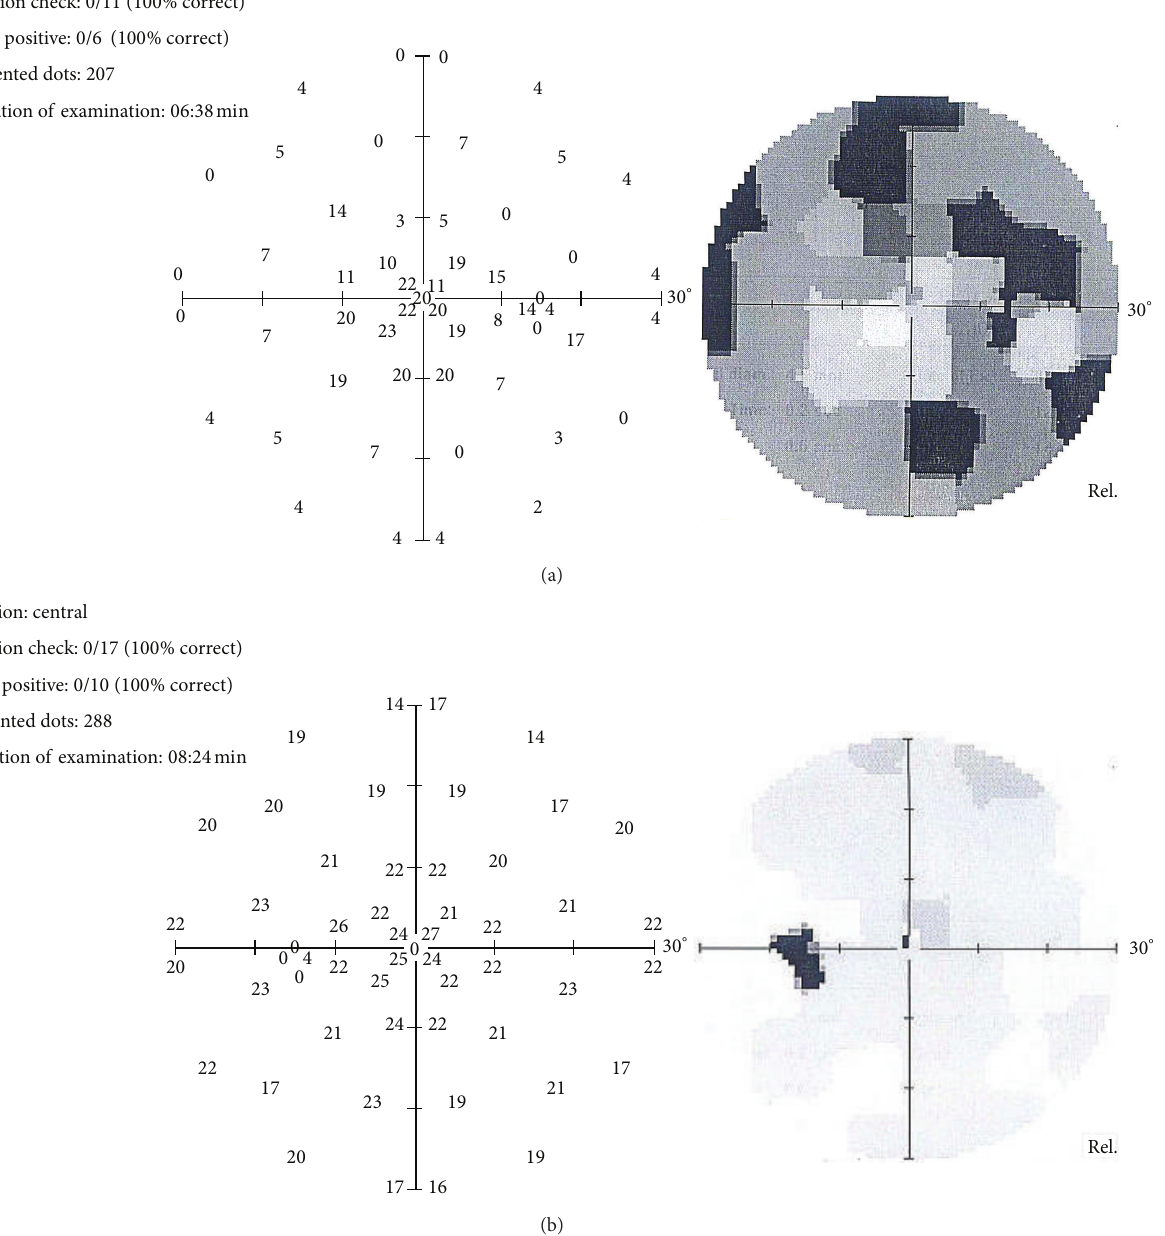
Figure 3: (a) Arcuate defects in the right eye’s visual field examination. (b) Normal visual field findings in the left eye.